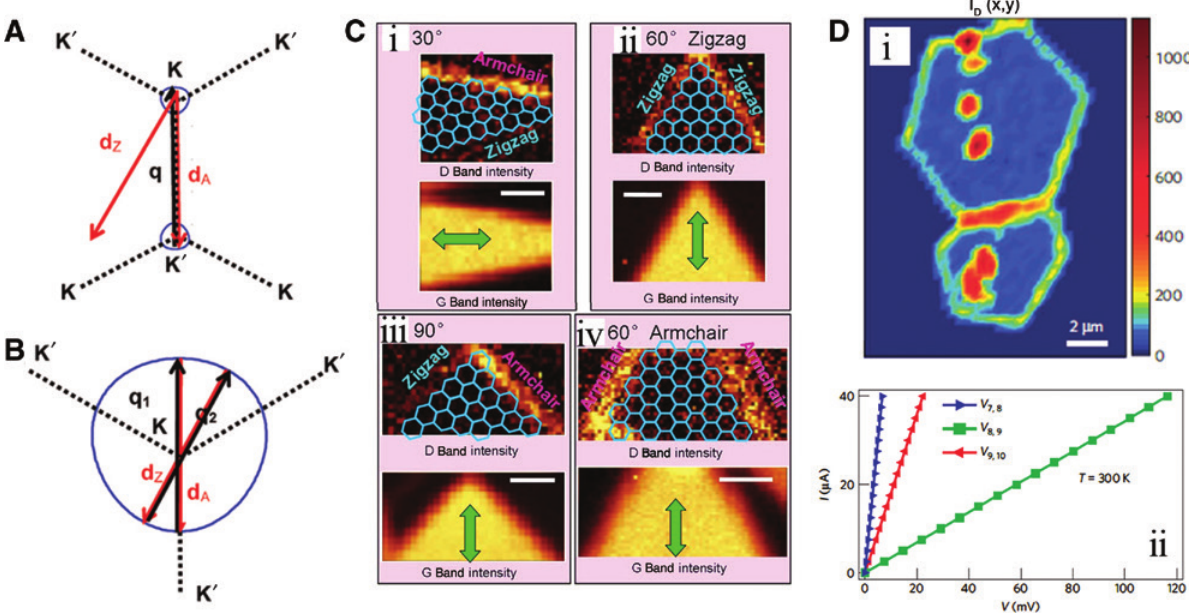
can connect K and K ′ . (B) Schematic A and d , can connect points belonging to the Z A , V ) and across the 7,8 9,10